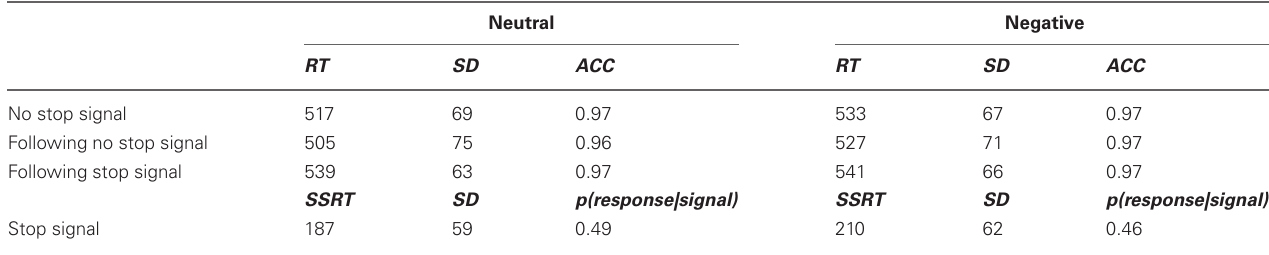
Table 1 | Reaction time ( RT in ms ), standard deviation ( SD ), and accuracy ( ACC ) of the different trials in the two valance conditions (Neutral and